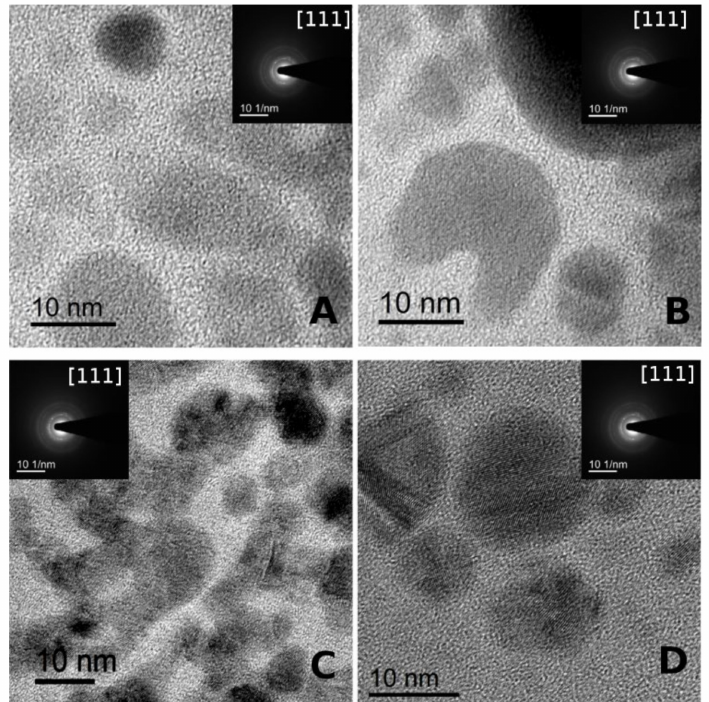
Figure 4. High-resolution transmission electron microscopy (HR-TEM) image of silver nanoparticles (AgNPs) and their fast Fourier transform (FFT). ( A ): Ag / S 1 G ( B ): Ag / S 1 R ( C ): Ag / S 8 G. ( D ): Ag / S 8